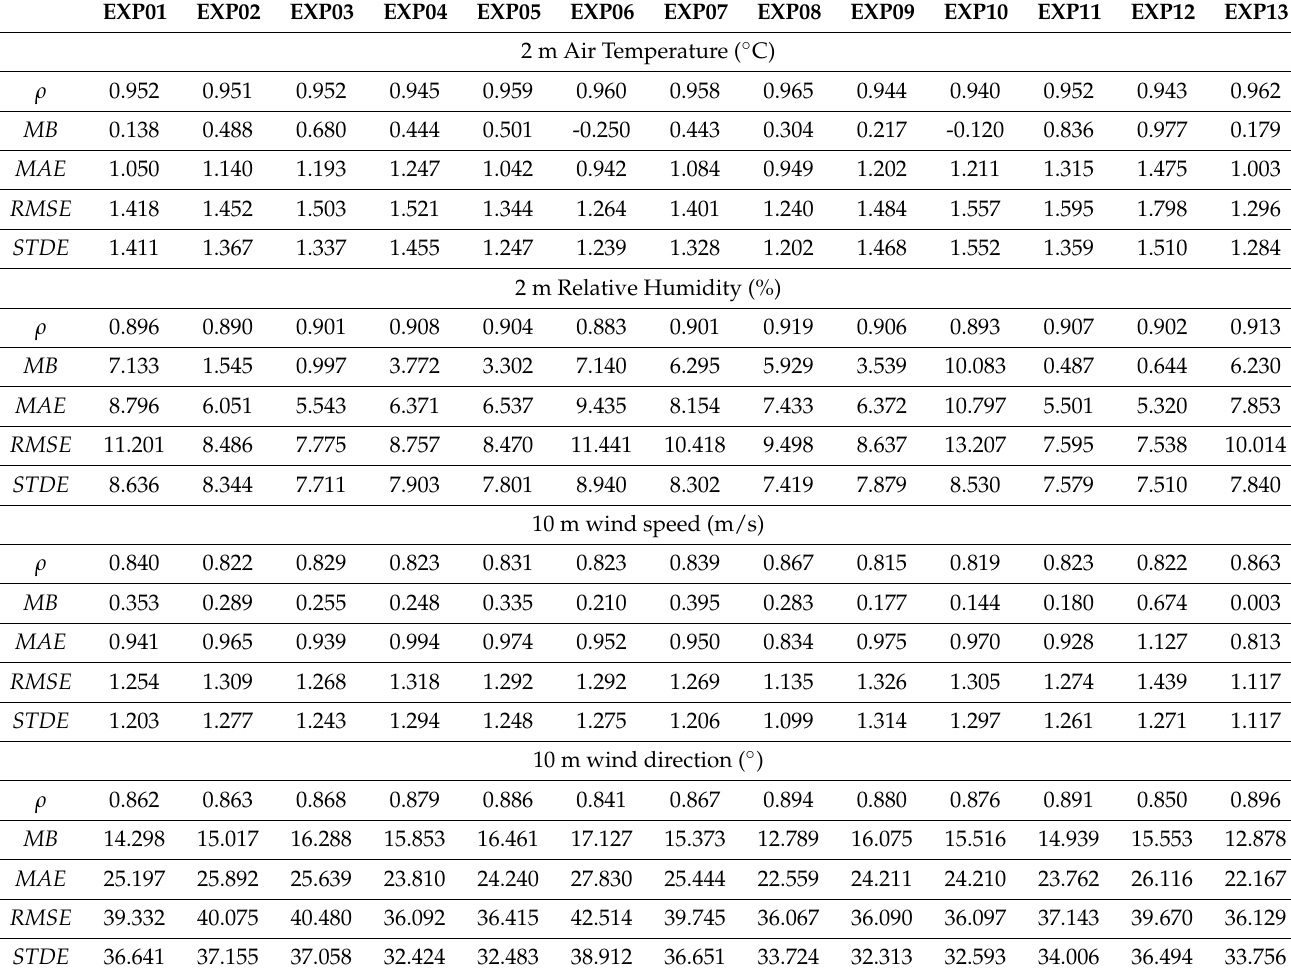
Table 5. Statistical metrics calculated for January 2019 hourly data at Barakah